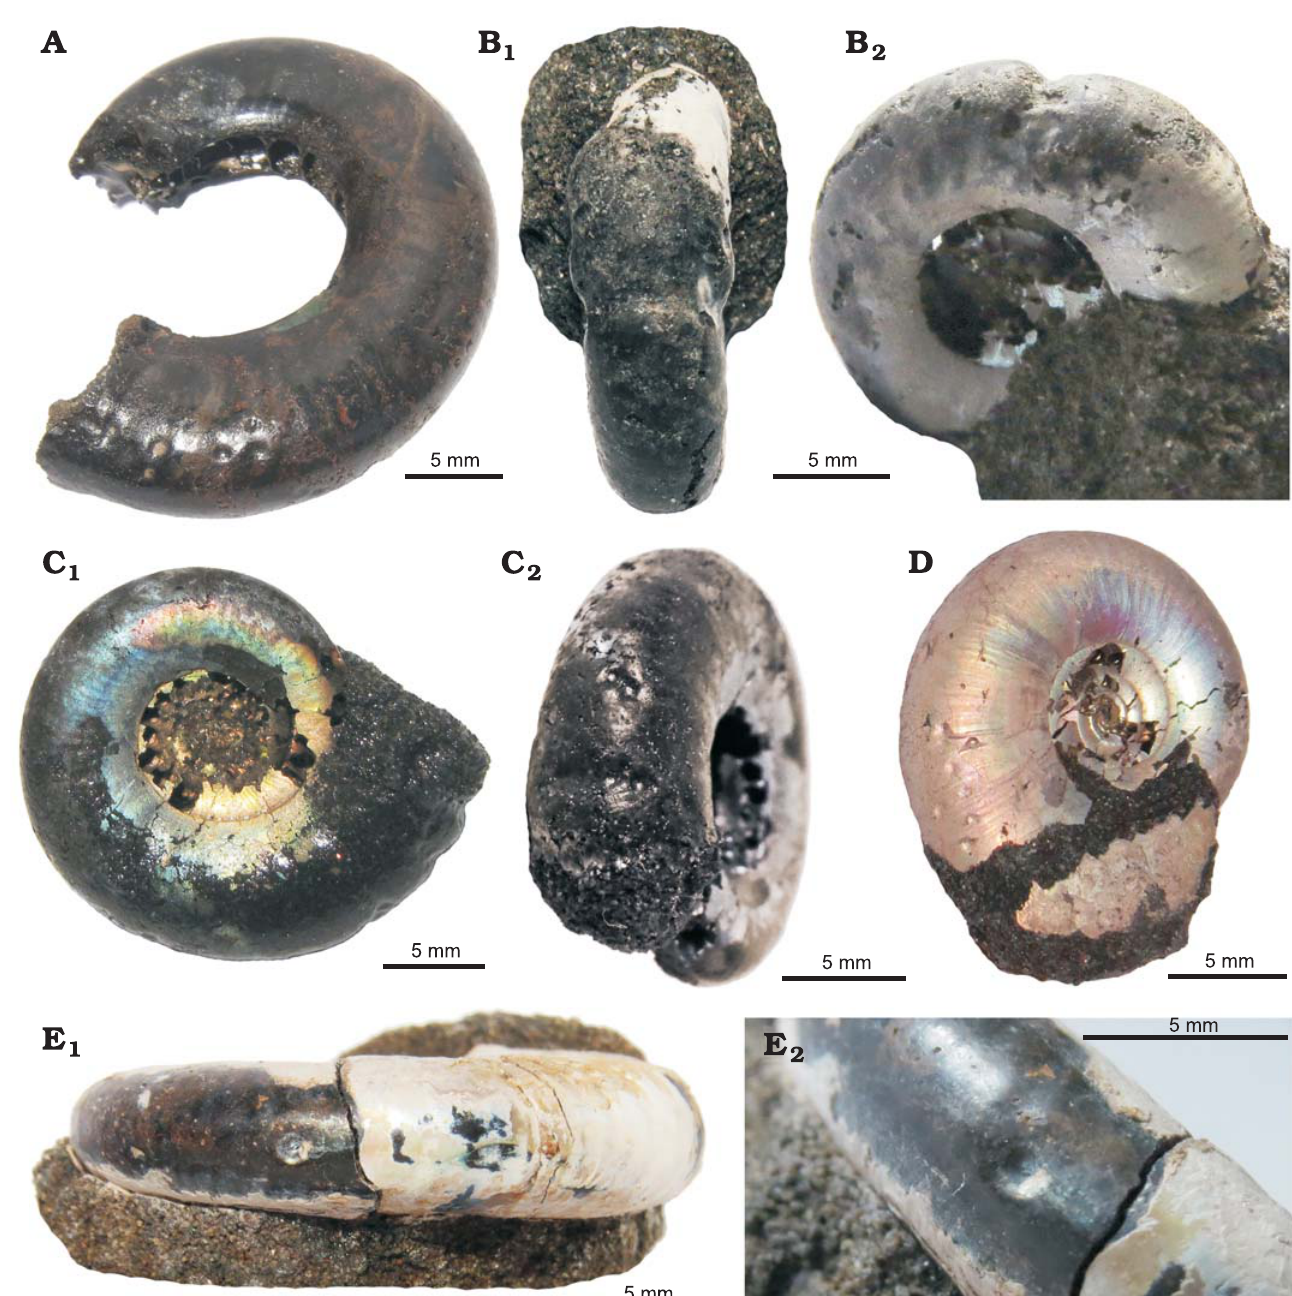
Fig. 8. Craspeditid ammonites Kachpurites fulgens (Trautschold, 1861) from the Late Volgian, Kachpurites fulgens Zone, Moscow region, Central Russia, Mnevniki (A) and Eganovo (B − E) locality; shells with pits. A . MSU 118/2, fully preserved body chamber with pits, which are clearly visible not far from the aperture; lateral view. B . MSU 118/3, shell with abnormal constriction on the body chamber; in ventral (B 1 ) and lateral (B 2 ) views. C . MSU 118/4, shell with fully preserved body chamber; in lateral (C 1 ) and ventral (C 2 ) views. There are abnormally small lateral attachment scars (on the top of the C 1 ) and pits on the apertural part of the shell. D . MSU 118/5, shell without aperture and with pits which are located ventro-laterally; lateral view. E . MSU 118/6, body chamber fragment without aperture and phragmocone; ventral view (E 1 ), enlarged view of the pit (E 2 ). There is only one relatively large pit on this